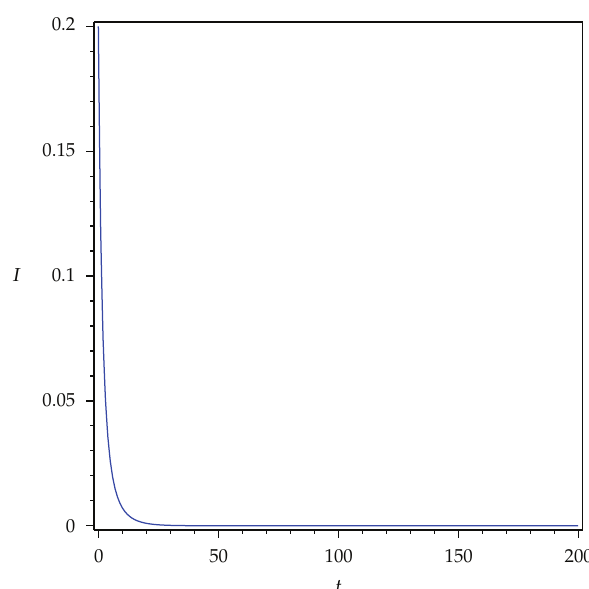
Figure 8: Time series of I (cid:3) t (cid:4) with parameters ρ (cid:7) 0 . 8 , μ (cid:7) 0 . 2 , β (cid:7) 1 . 2 , α (cid:7) 1 , r (cid:7) 0 . 6 , d (cid:7) 0 . 2 , ω (cid:7) 0 . 1 , T (cid:7) 1 , and τ (cid:7) 0.